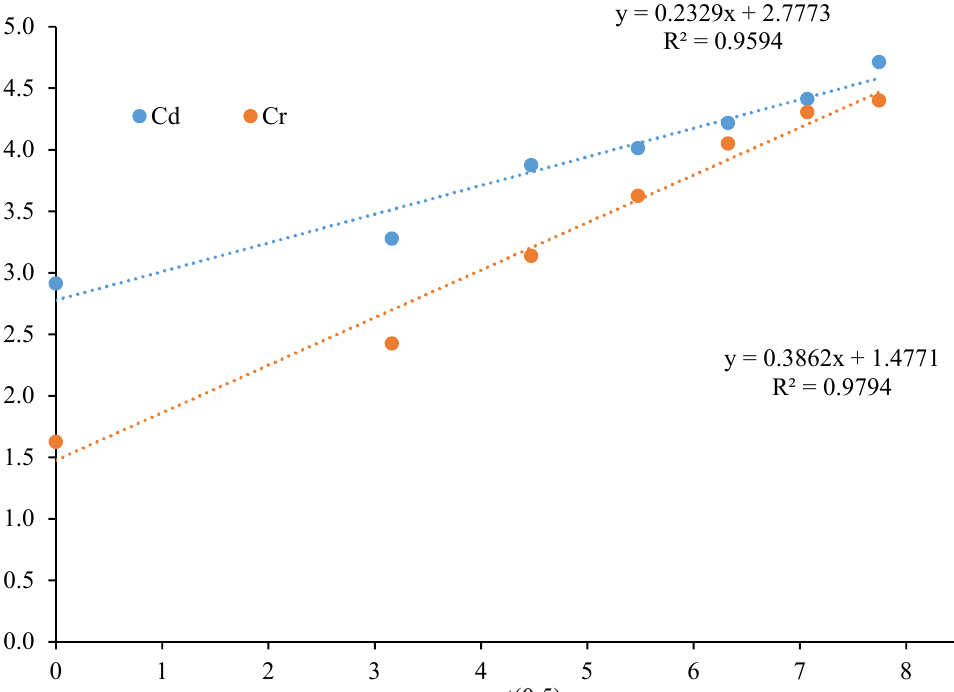
Figure 10. Pseudo-second-order kinetic plot of metal adsorption on the CeO 2 /corncob nanocomposite.